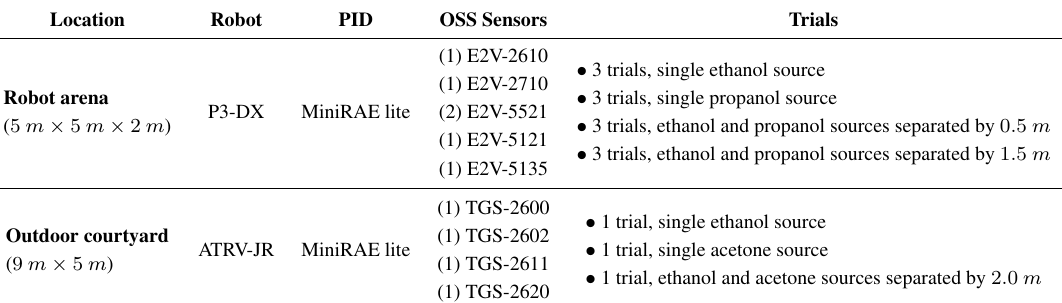
Table 1. Summary of the experimental configurations during the validation trials.